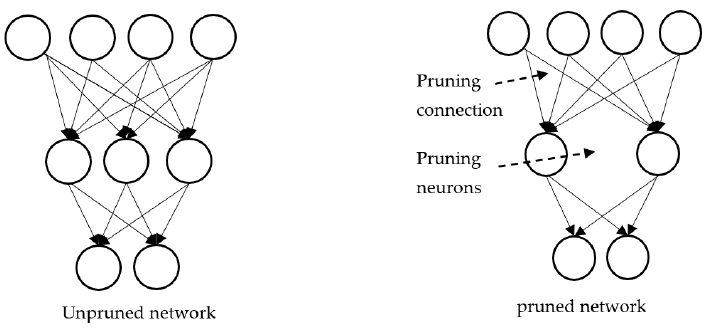
Figure 11. Pruning of connections and neurons.